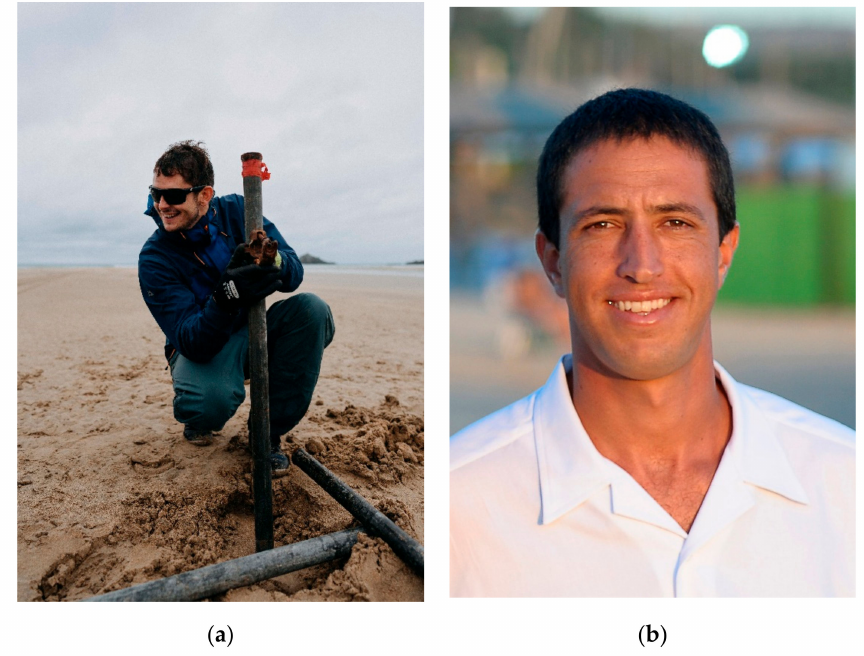
Figure 1. ( a ) Mr. Oliver J. Billson; ( b ) Dr. Gal